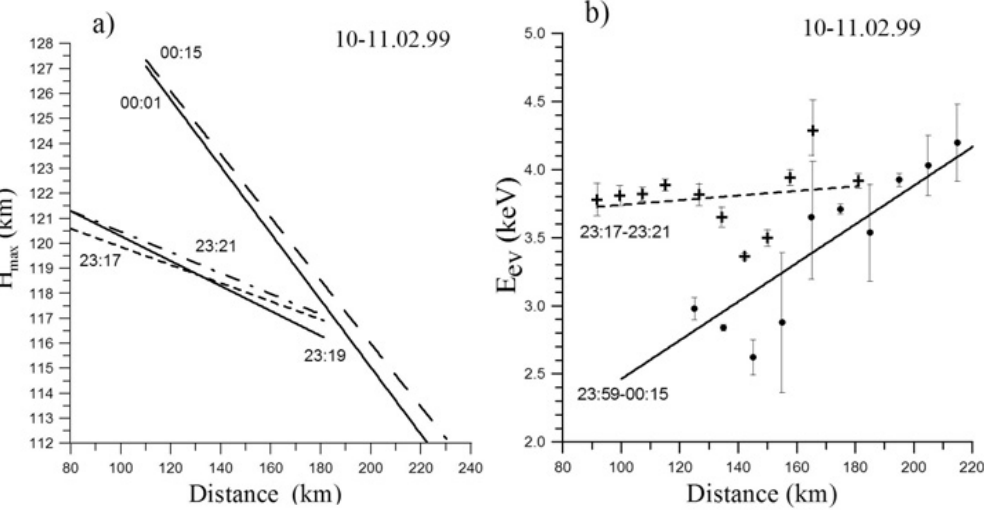
Fig. 7. Variations of the altitude of peak of the 427.8-nm volume emission rate along the meridian (a) and the mean energy of the precipitating electrons (b) at various times in a wide observational sector. The mean electron energy is averaged individually during both events when we observed only one arc at 23:17–23:21 UT or two arcs at 23:50–00:15 UT. The vertical bars indicate the confidence